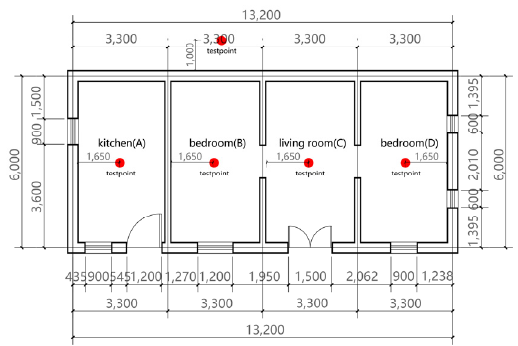
Figure 6. Layout of the traditional slate dwellings.